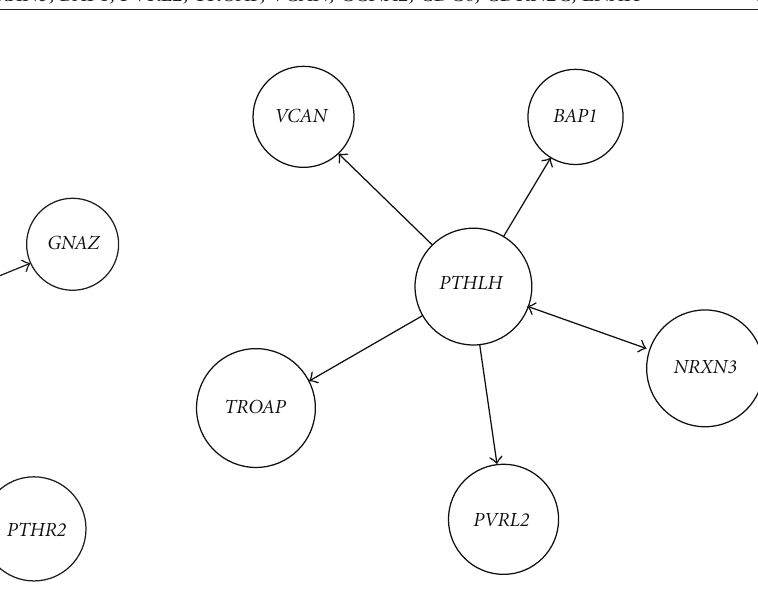
Figure 2: Activated PTHLH feedback cell adhesion network construction including di ff erent molecules but same GO term and same molecule but di ff erent GO terms in HCC from the same activated PTHLH GO-molecular network of HCC compared with the corresponding activated GO-molecular network of no-tumor hepatitis/cirrhotic tissues by GRNInfer and our